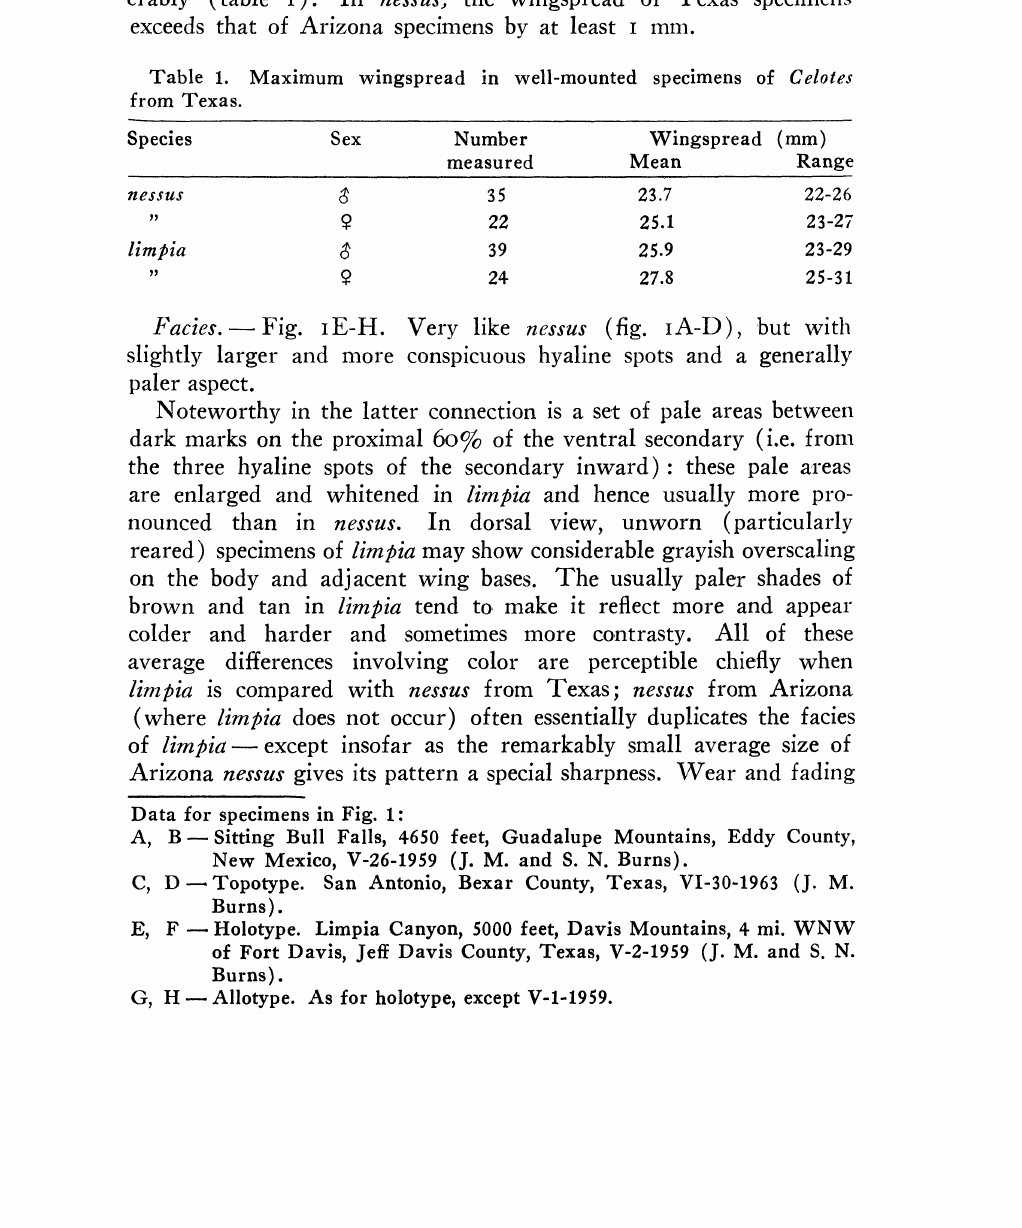
Table 1. Maximum wingspread in well-mounted specimens of Celotes from Texas. Species Sex Number Wingspread (mm) measured Mean Range